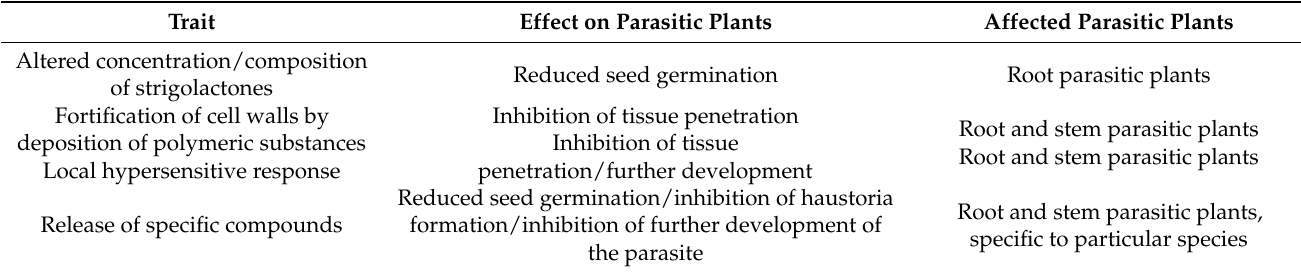
Table 2. Overview of the established host plant resistance